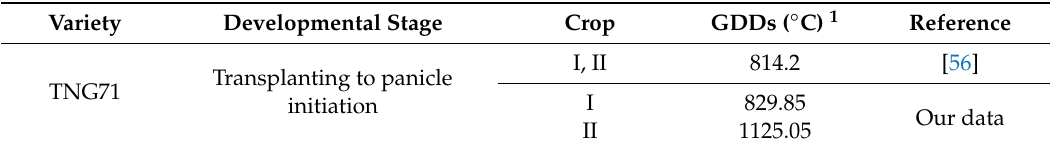
Figure 11. Plant height and the variation of the highest and lowest temperature with cultivation processes in ( a ) the first crop season; and ( b ) the second crop season. Table 2. Comparison of the growing degree days of TNG71 predicted by a previous model and the field survey in the first and second crop seasons in